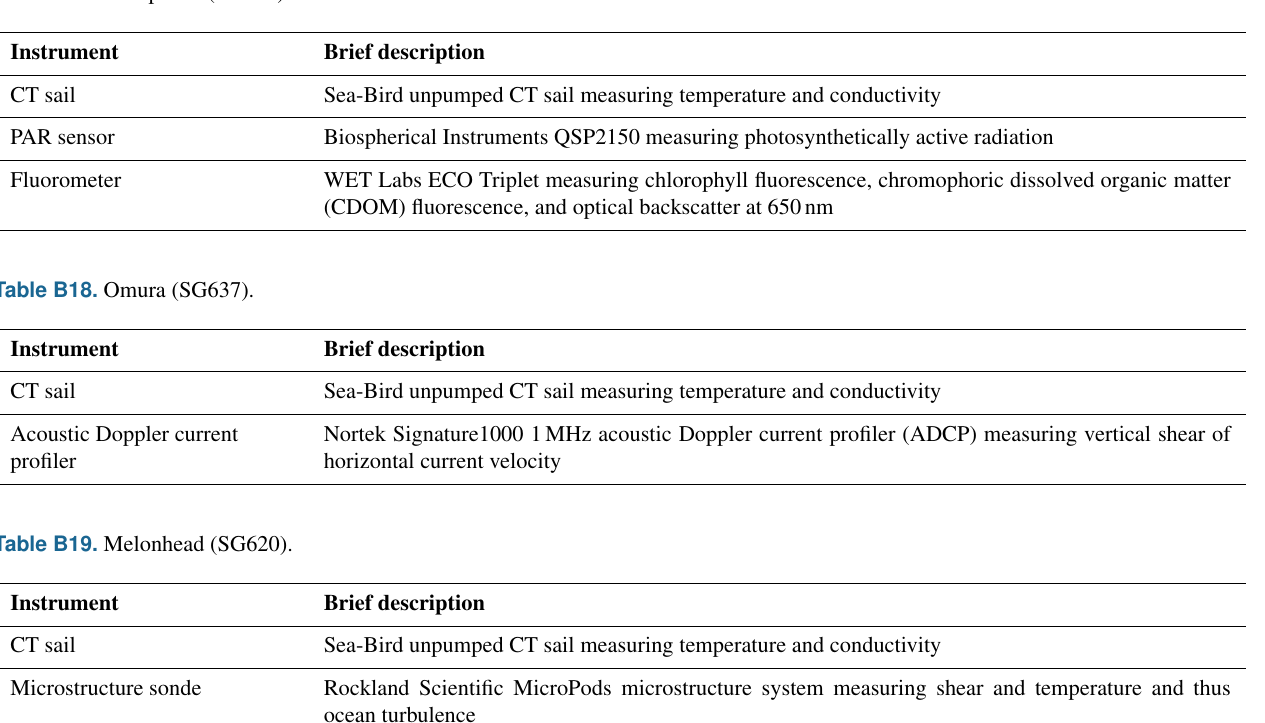
Table B17. Humpback (SG579).